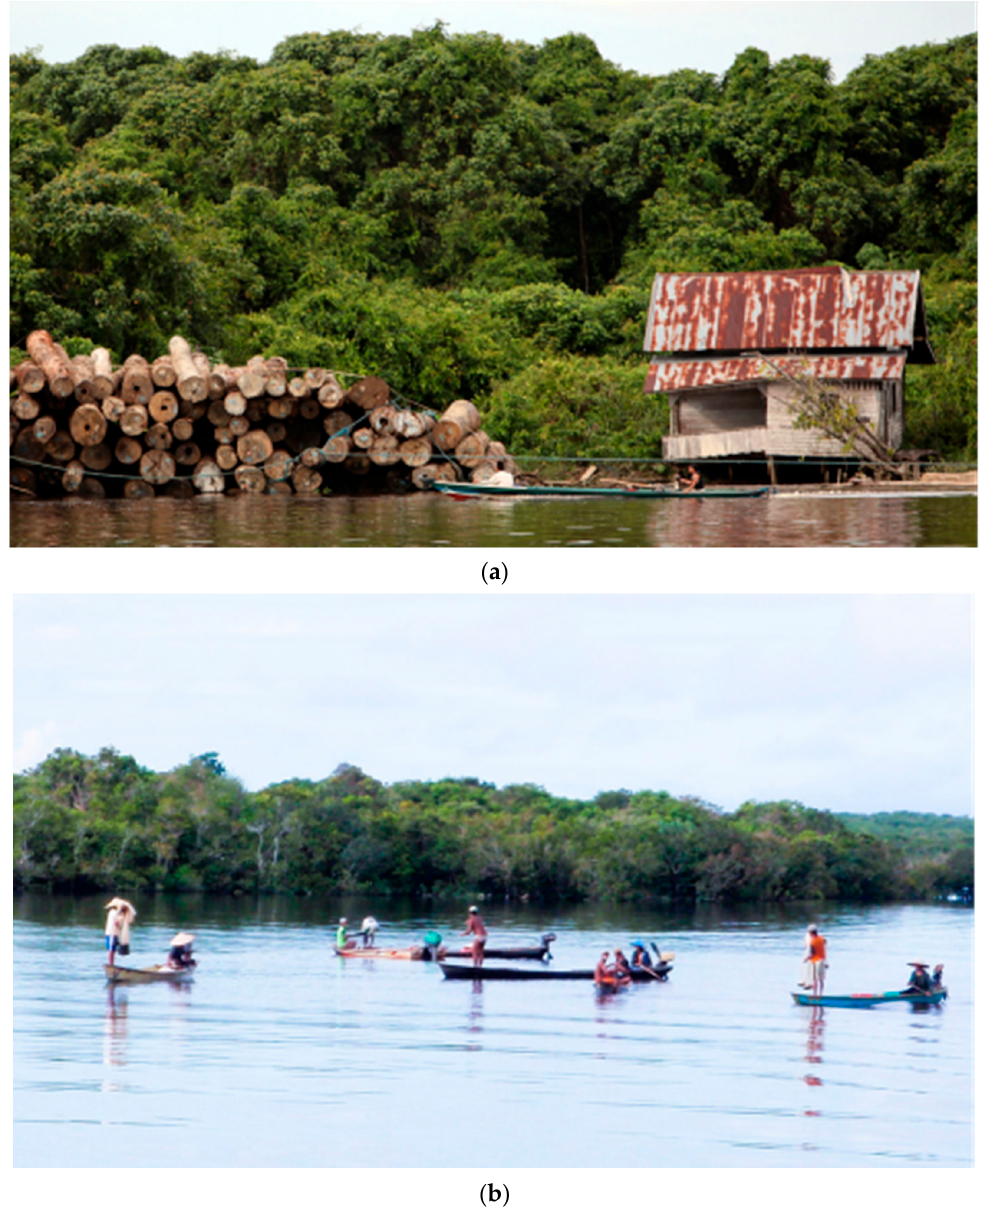
Figure 8. Community residents demand for some natural resources. ( a ) “Kalimantan deforestation and degradation 3” by DFAT photo library is marked with CC BY 2.0; ( b ) “Communal fishing” by CIFOR is marked with CC BY-NC-ND 2.0.